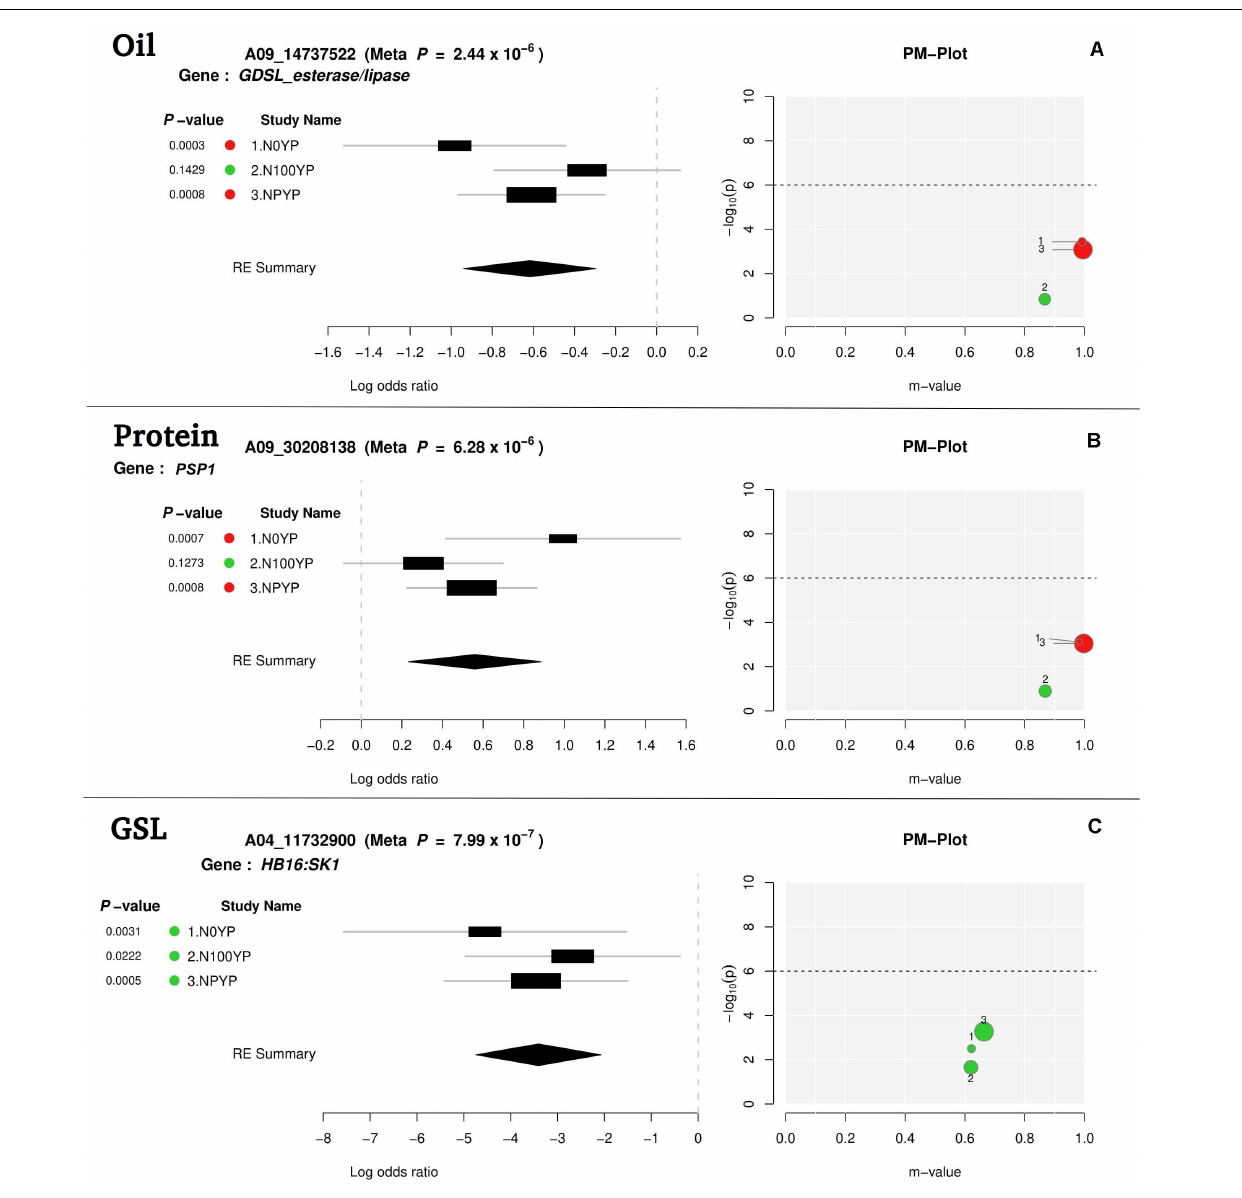
FIGURE 4 | Meta-analysis output file for oil (A) , protein (B) , and glucosinolates content (C) (one gene for each